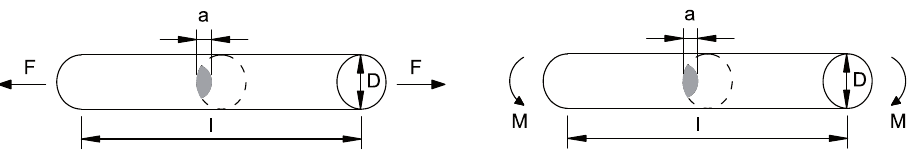
Figure 1: Cracked bar under tension loading (left) and bending moment (right).